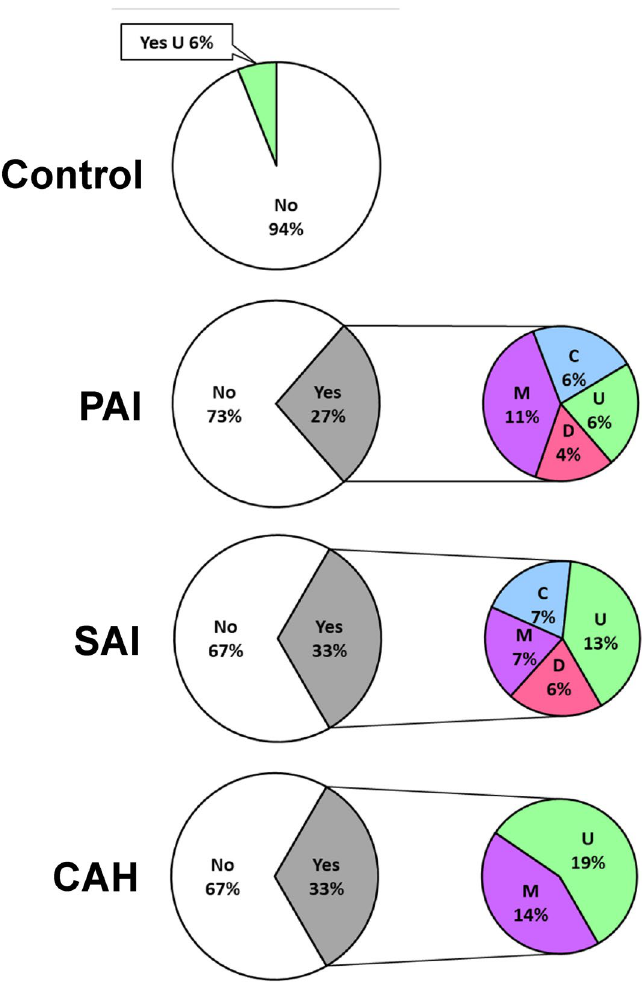
Figure 3. Percentage of patients fulfilling Rome IV criteria for the diagnosis of irritable bowel syndrome. Left pie chart—white: no (no IBS criteria), grey: yes (IBS criteria). The two control subjects fulfilling IBS criteria were both unsubtyped IBS (Green: U); right pie chart (IBS subtypes)—red: diarrhea IBS criteria (D), blue: constipation IBS criteria (C), purple: mixed bowel habits IBS criteria (M) and green: unsubtyped IBS (U).